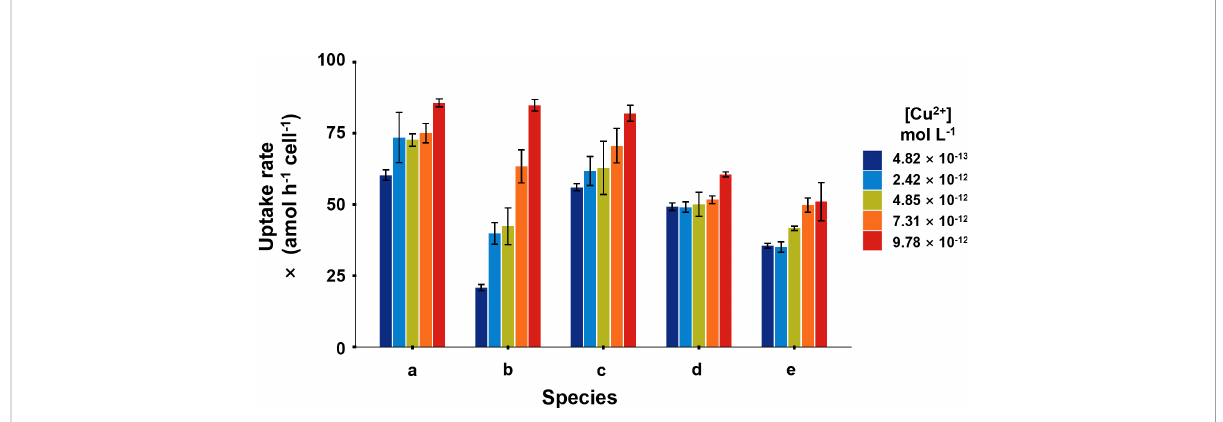
FIGURE 1 Cu uptake rates of fi ve phytoplankton, in which (A) , Isochrysis zhanjiangensi , (B) , Phaeocystis sp., (C) , Isochrysis galbana , (D) , Chaetoceros sp. and (E) , Phaeodactylum tricornutum at 4.82 × 10 -13 , 2.42 × 10 -12 , 4.85 × 10 -12 , 7.31 × 10 -12 , 9.78 × 10 -12 mol L -1 [Cu 2+ ] for 2-hour